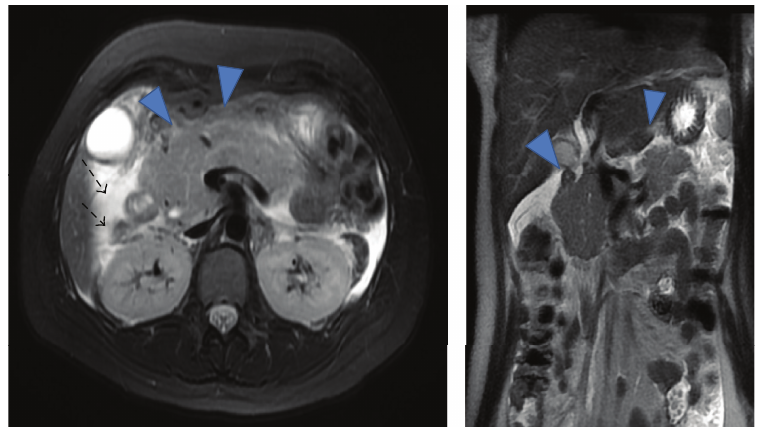
Figure 1: MRI T2W. ( 󳶃 ) Enlargement of the pancreatic body. ( → ) Inflammation of acute pancreatitis, extending to fat tissue and reaching beyond the lower pole of the kidney.